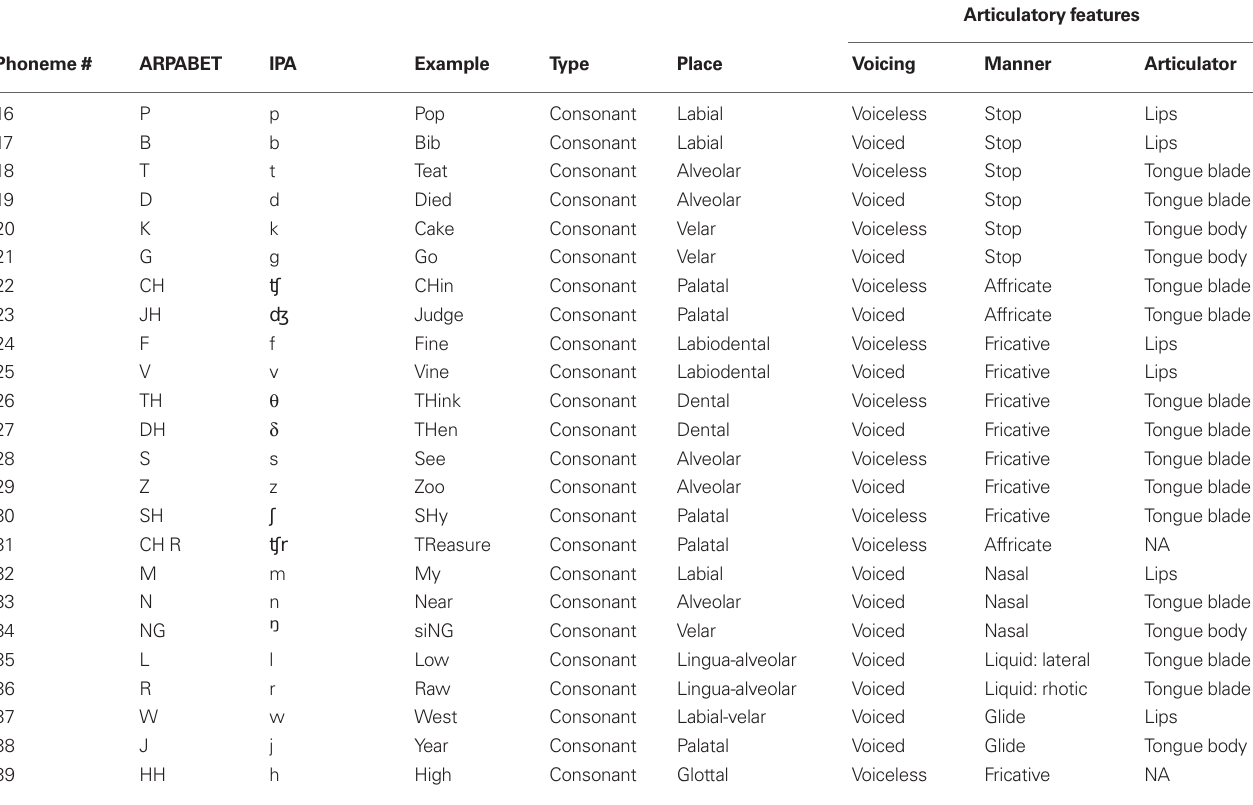
Table 2 | Consonant stimuli used for the phoneme production